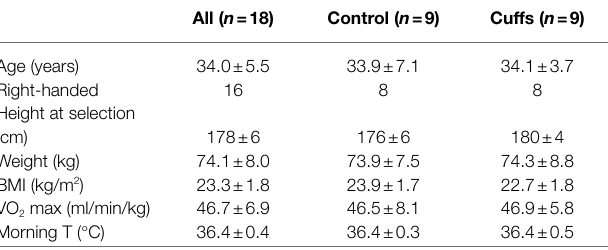
TABLE 1 | Baseline group characteristics at